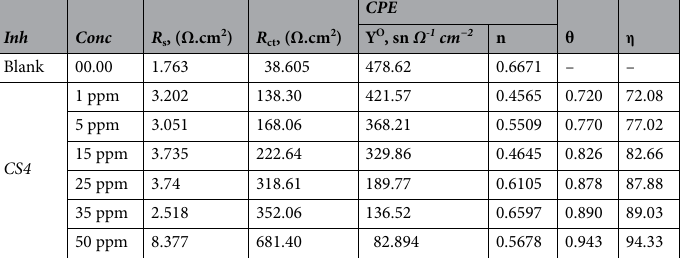
Inh Conc R s , (Ω.cm 2 ) R ct , (Ω.cm 2